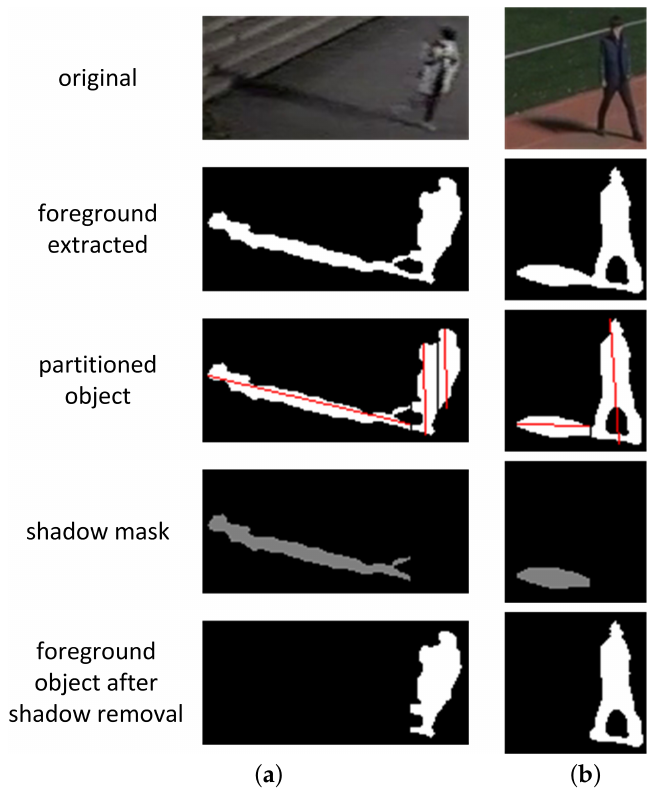
Figure 11. Results in each step in the proposed shadow detection algorithm: ( a ) Sequence S5, frame 1280; ( b ) Sequence S3, frame